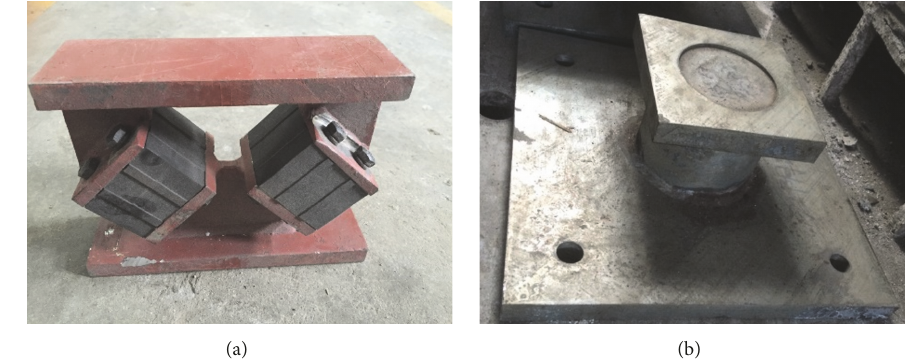
Figure 15: Scaled models: (a) novel antivibration bearing and (b) steel bearing.